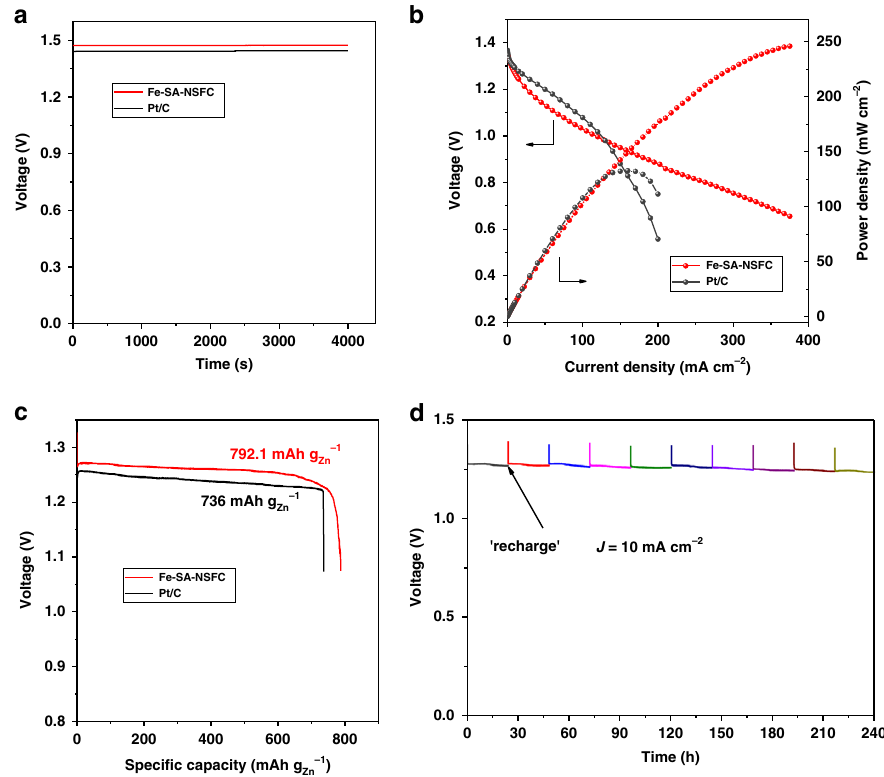
Fig. 5 Performance of the Fe-SA-NSFC and Pt/C catalysts in a Zn-air battery. a The open-circuit voltage curves, b discharge polarization curves and corresponding power density plots, and c long-term galvanostatic discharge curves. The speci fi c capacity was normalized to the mass of consumed Zn. d “ Recharging ” the Zn-air battery with Fe-SA-NSFC as the cathode catalyst by replenishing the Zn anode and